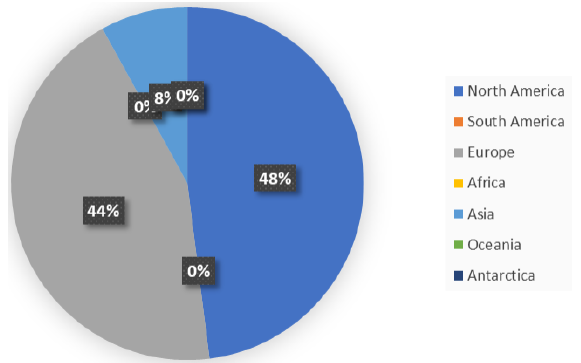
Figure 3. Cyber-Attacks by